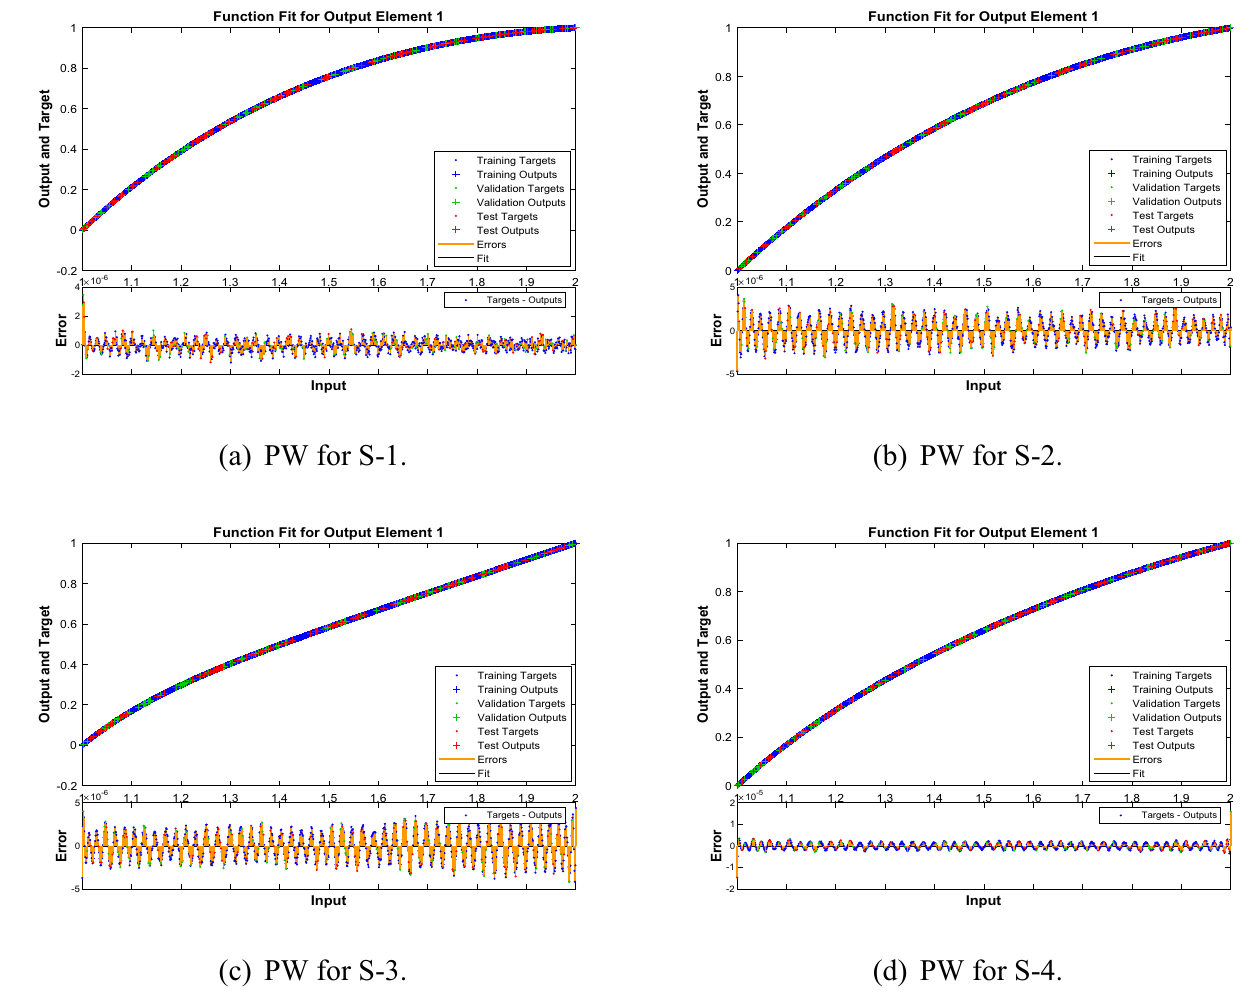
Figure 15. Reference solution comparison with LMA-TNN based performance view (PW) in Vogel’s